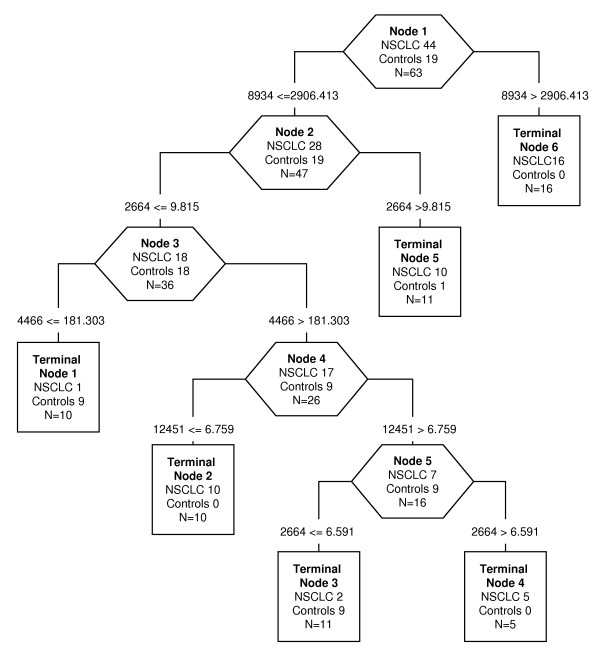
Decision tree classification diagram of low-MW serum protein peaks from NSCLC patients and controls, applying the IMAC30-Cu conditions. The numbers in the root (top), descendant nodes (exagons) and terminal nodes (rectangles), represent the classes (NSCLC and controls, N = sum of NSCLC and controls subjects). The numbers below the root and the descendant nodes indicate the values of mass peak and its intensity, respectively.